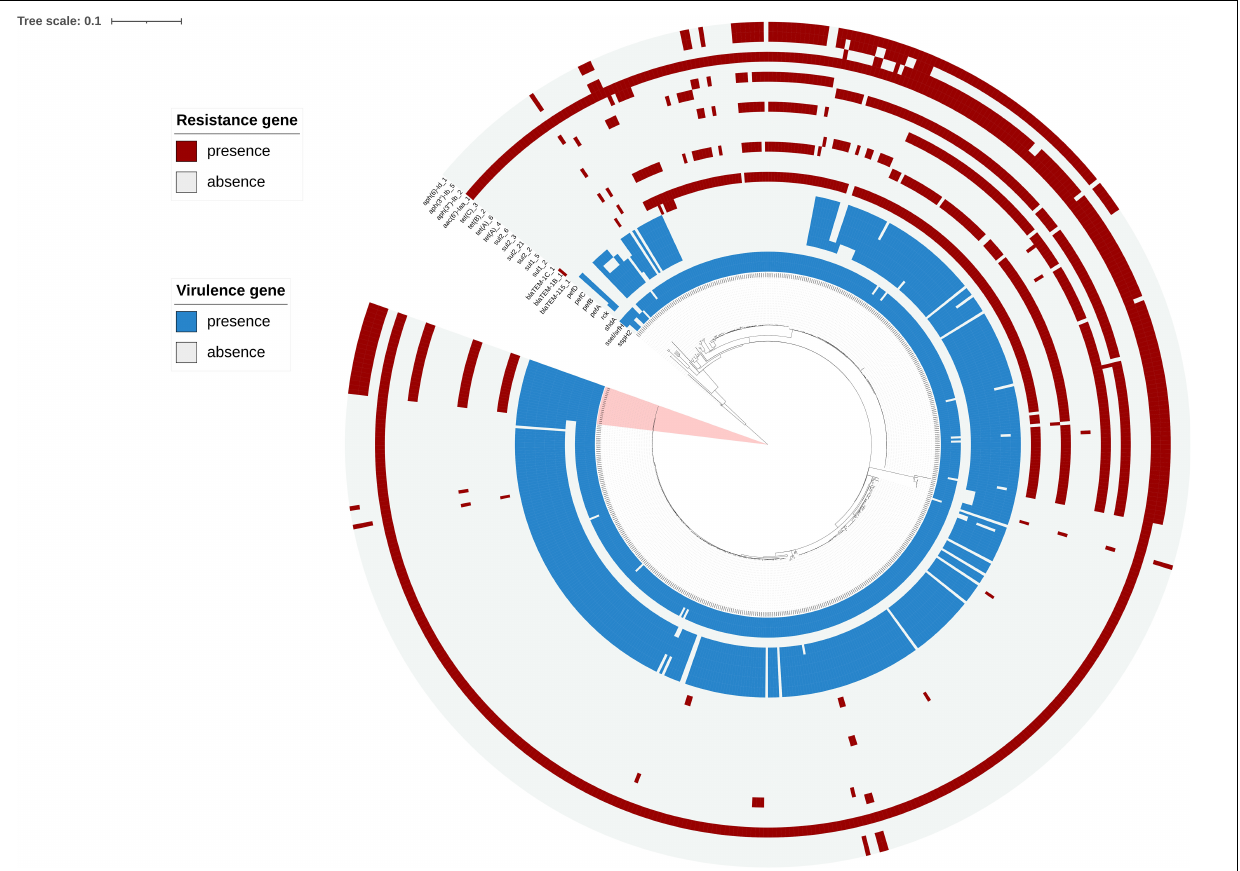
FIGURE 3 | Phylogenetic analysis based on 533 genomes including 20 genomes from the outbreak strains and 513 public genomes. The outbreak strains are light pink areas. Presence and absence of resistance genes were represented by dark red and light gray colors, respectively. Presence and absence of virulence genes is represented by dark blue and light gray colors,